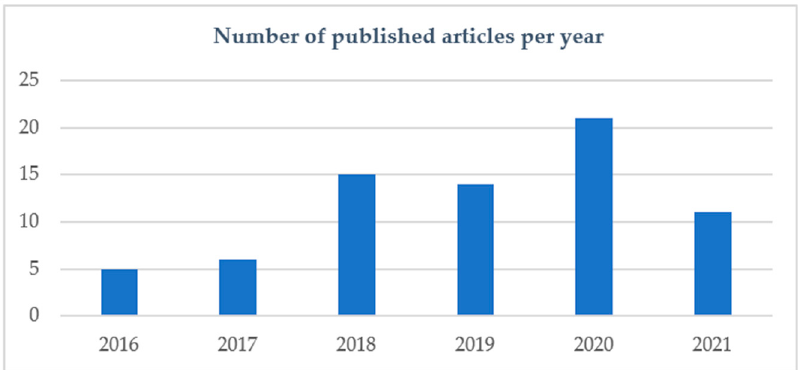
Figure 1. Number of publications from 2016 to 2021 on VSM 4.0.